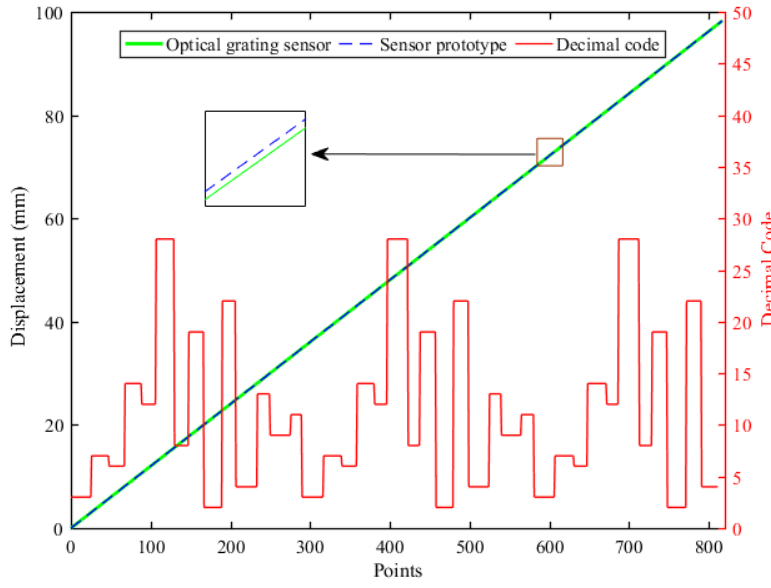
Figure 11. Sensor displacement measurement results and coding results.